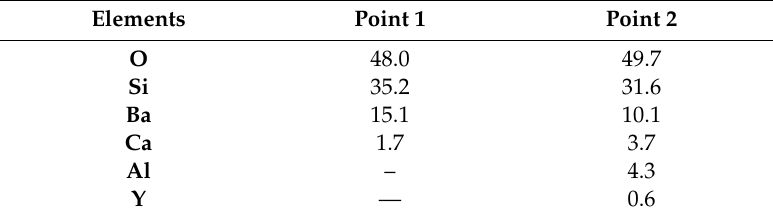
Table 3. EDS point analyses (at. %) performed on the HJ28 glass-ceramics as shown in Figure 4.